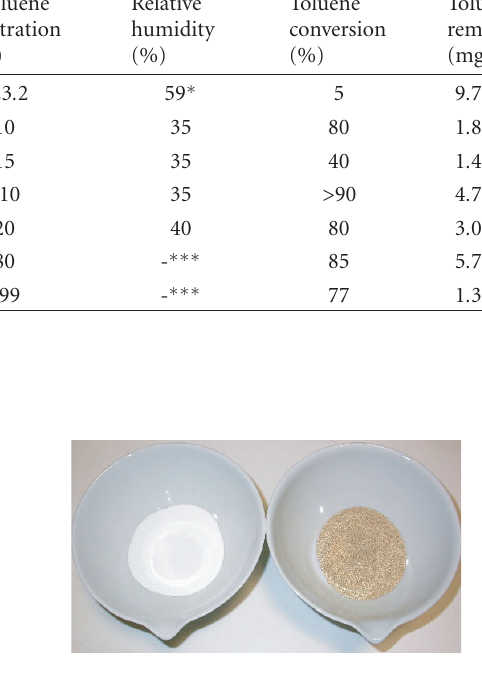
Figure 7: Activated and deactivated